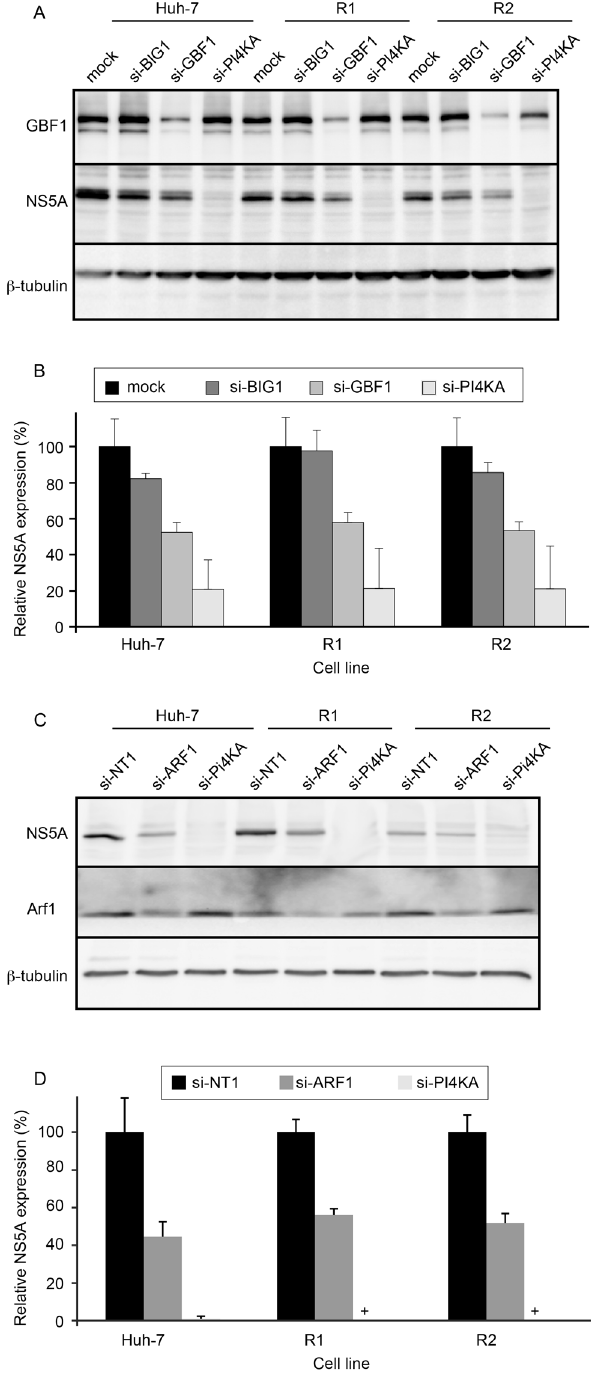
Figure 3. Impact of GBF1 and Arf1 depletion on HCV replication in R1 and R2 cells. (A) Cells of the indicated cell lines were transfected with siRNA targeting GBF1, BIG1, or PI4KIII a (PI4KA), and infected with HCVcc. Cells were lysed at 30 hpi and the expression of NS5A, GBF1, and b -tubulin were analyzed by immunoblotting. (B) For each cell line, NS5A expression is expressed as a percentage of the values obtained for mock-transfected cells. (C) Cells of the indicated cell lines were transfected with siRNA targeting Arf1 or PI4KIII a (PI4KA), or with a non-targeting control siRNA, and infected with HCVcc. Cells were lysed at 30 hpi and the expression of NS5A, Arf1, and b -tubulin were analyzed by immunoblotting. (D) For each cell line, NS5A expression is expressed as a percentage of the values obtained for the control